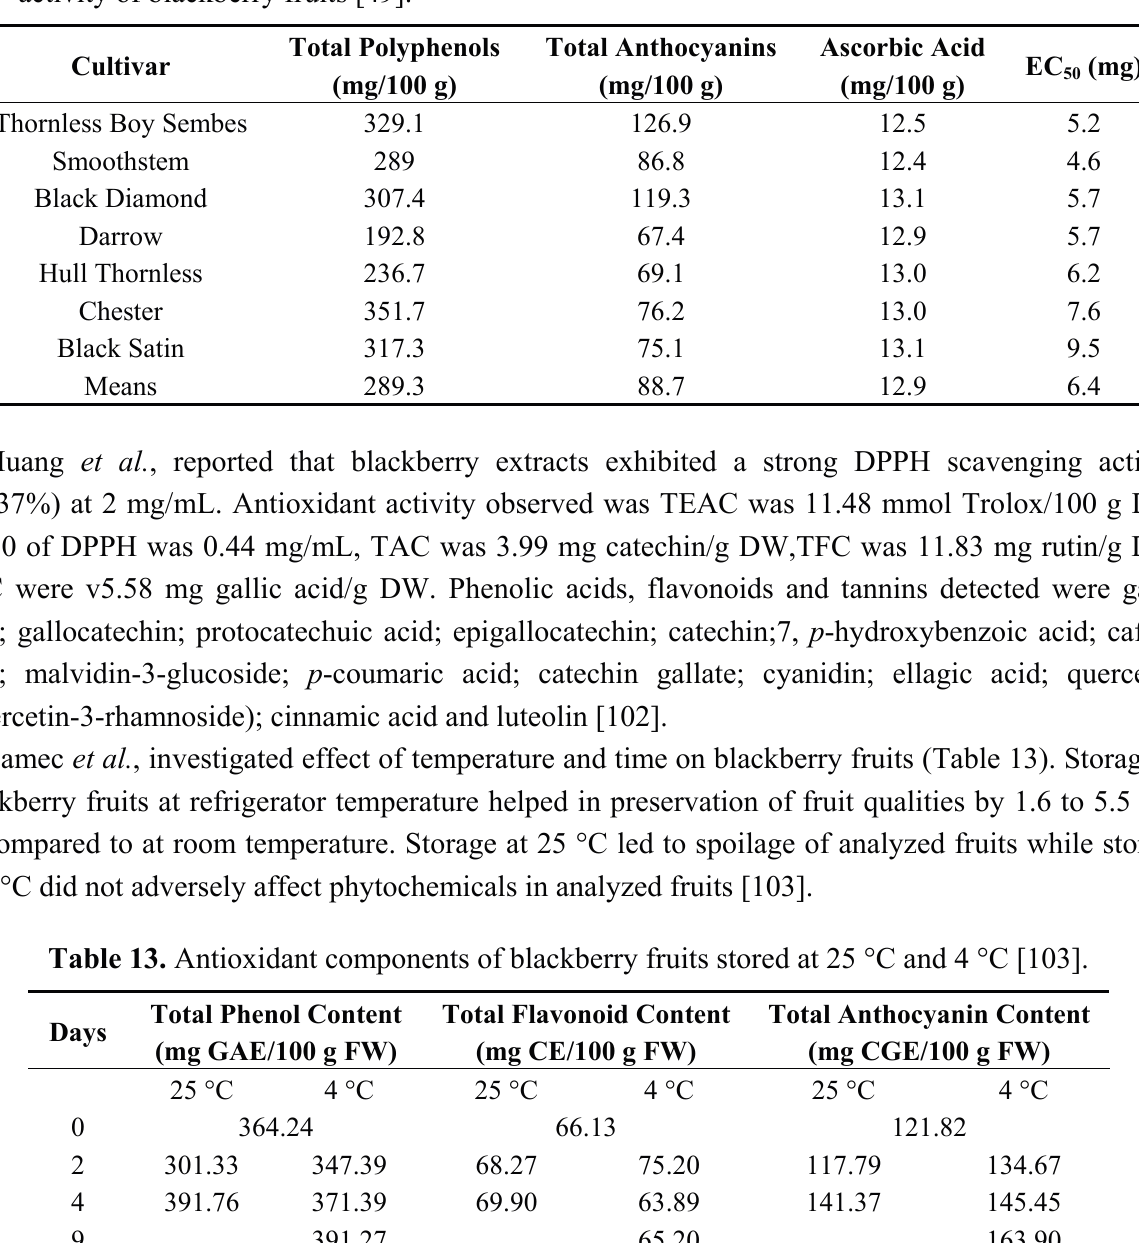
Table 12. Phenolic, anthocyanin and ascorbic acid contents and DPPH radical scavenging activity of blackberry fruits [49].